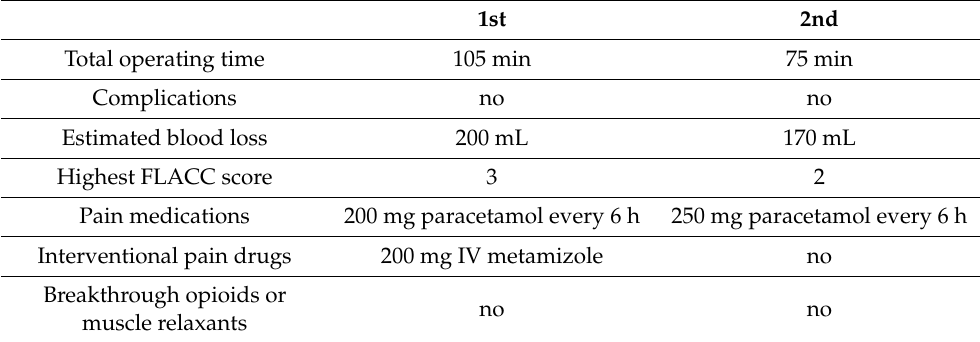
Table 2. Surgery and postoperative